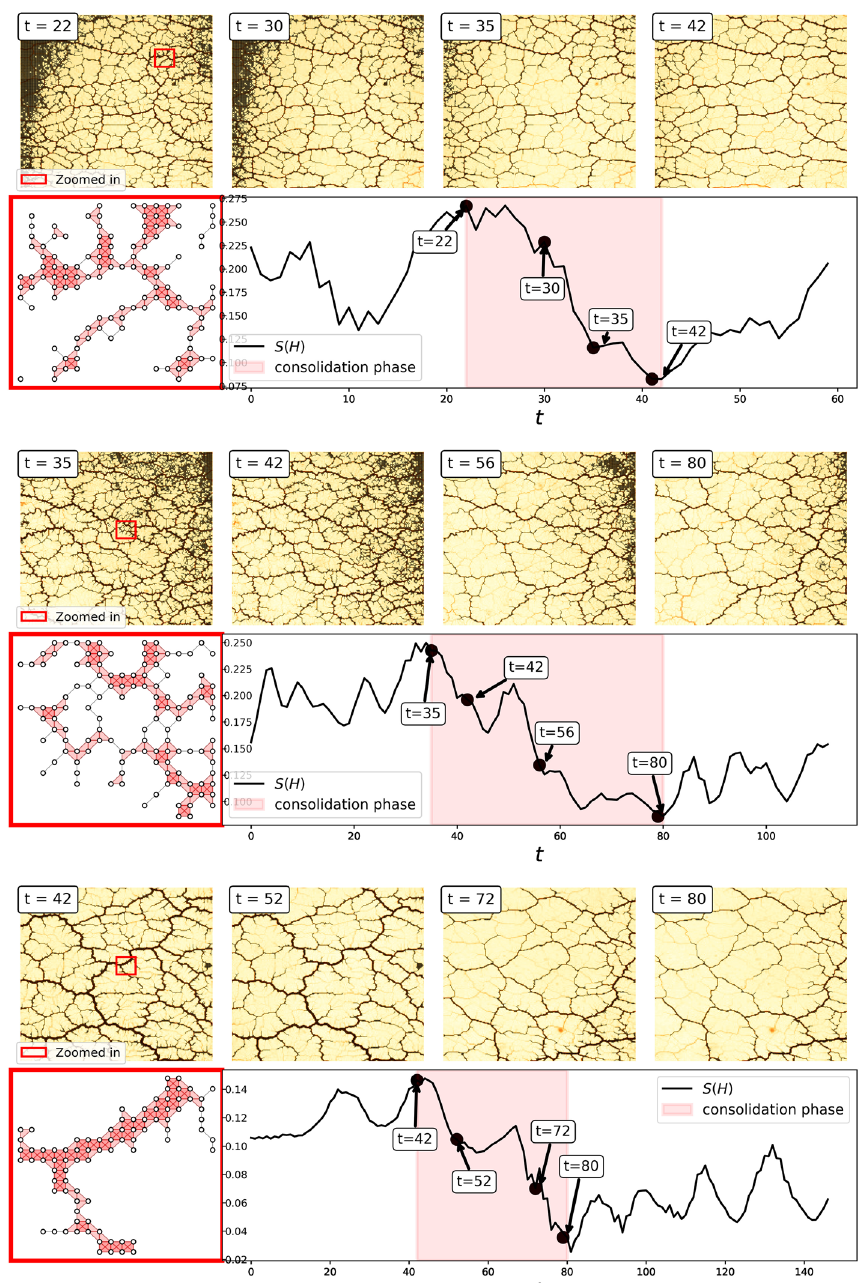
Fig. 10 P. polycephalum S evolution. From top to bottom: motion24, motion40 and motion79 . Plots are separated in couples. For every couple, the plots on top show both P. polycephalum images and hypernetworks extracted from them. The hypernetwork at the lower leftmost plot is a subsection of the hypergraph shown inside the red rectangle on top. The plot at the bottom shows the covered area as a function of time. The red shade in this plot highlights a tentative consolidation phase towards